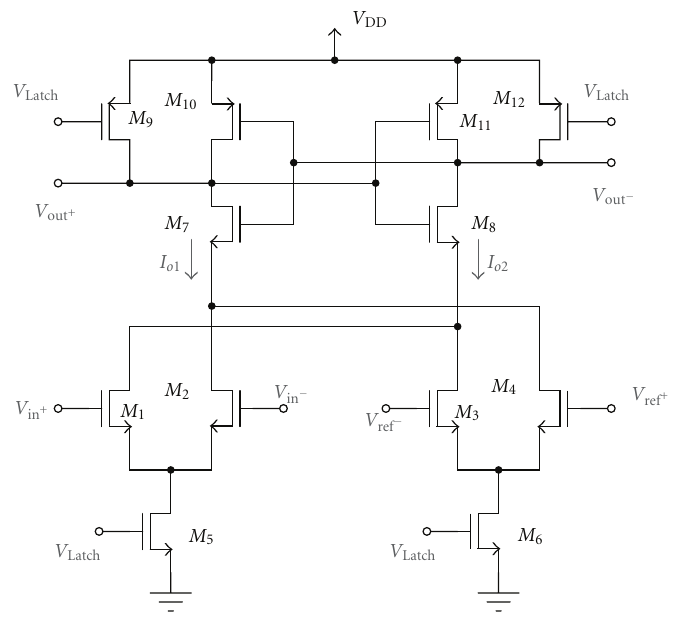
Figure 14: Comparator in the flash subADC.